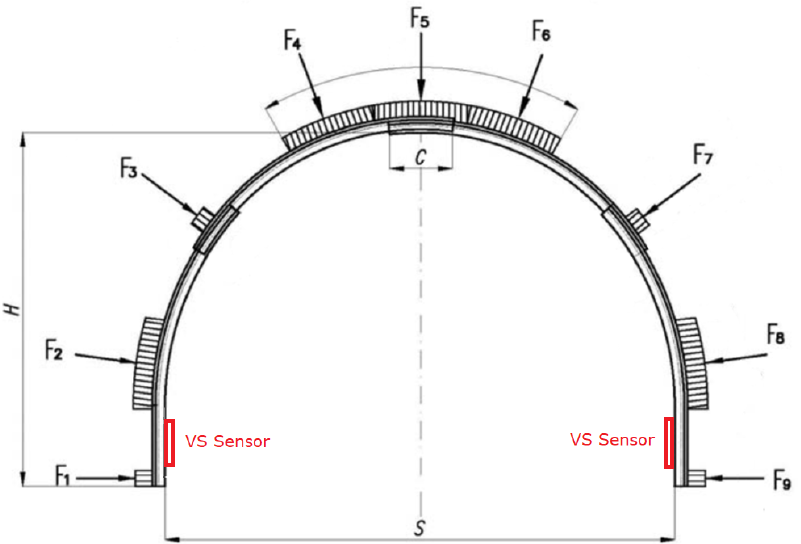
Figure 10. Diagram of loading ŁPP10/V29/4/A/I arch support frame during stand tests: F4, F5, F6—active forces; F1, F2, F3, F7, F8, F9—reaction forces (so-called passive resistance forces) based on [23].